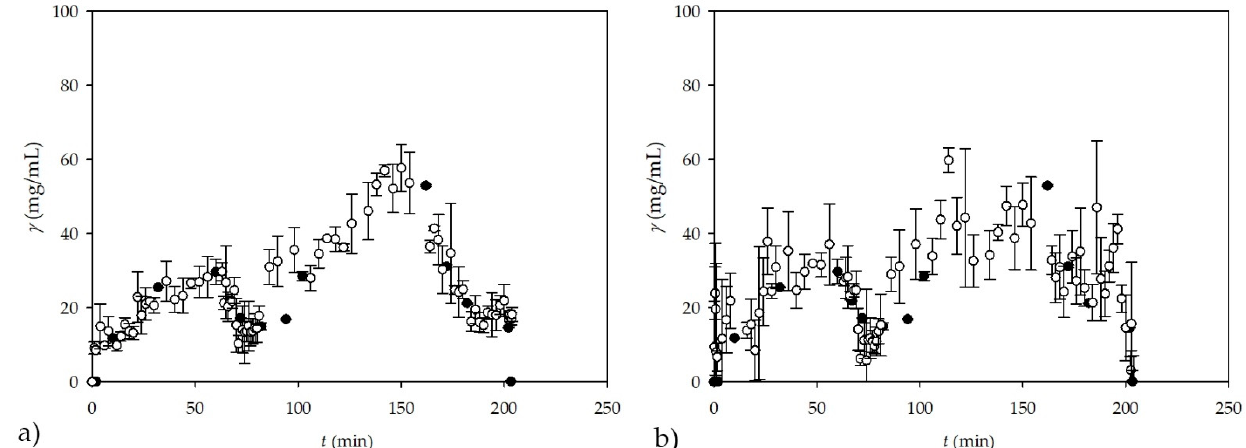
Figure 10. On-line measurement of glycerol concentration prediction by ( a ) ANN based on NIR spectroscopy for experiments performed in a +-shape microreactor for different residence times and ( b ) subsampling ANN based on NIR spectroscopy for experiments performed in a +-shape microreactor for di ff erent residence times ( ● — theoretical glycerol calculated from experimental data, ○ — ANN predictions).